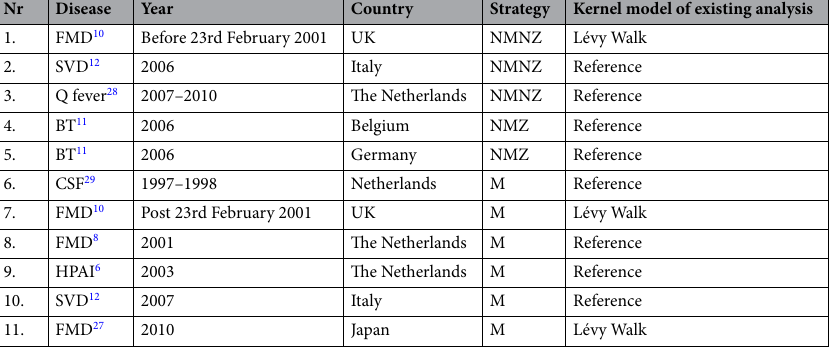
Table 1. List of 11 epidemic datasets analyzed, ordered by applied control strategy (in order of increasingly stringent measures: no movement ban nor zoning (NMNZ), no movement ban but zoning (NMZ), and a movement ban (M)) and year. Datasets 1 and 7 represent two time periods of one and the same epidemic; for brevity we often refer to all 11 datasets as ‘epidemics’ in the main text.